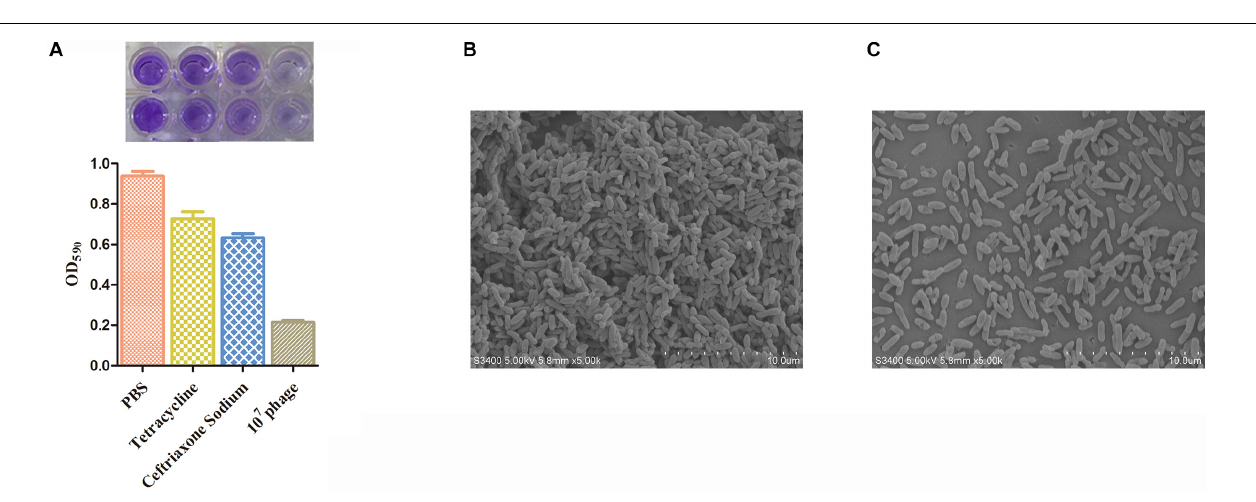
FIGURE 5 | Biofilm removal activity of IME-JL8. The reduction of biofilm after phage treatment with titers of 7 log10 PFU/mL and MIC concentration of cefoperazone sodium and tetracycline for 6 h. (A) Biofilm formation state was indicated by OD 590 values. (B,C) Micrographs of biofilms taken under the scanning electron microscopy. (B) The SEM of bacteria incubated overnight at 37 ◦ C. (C) The SEM of bacteria administrated with IME-JL8 for 6 h. The bars represent 10 µ